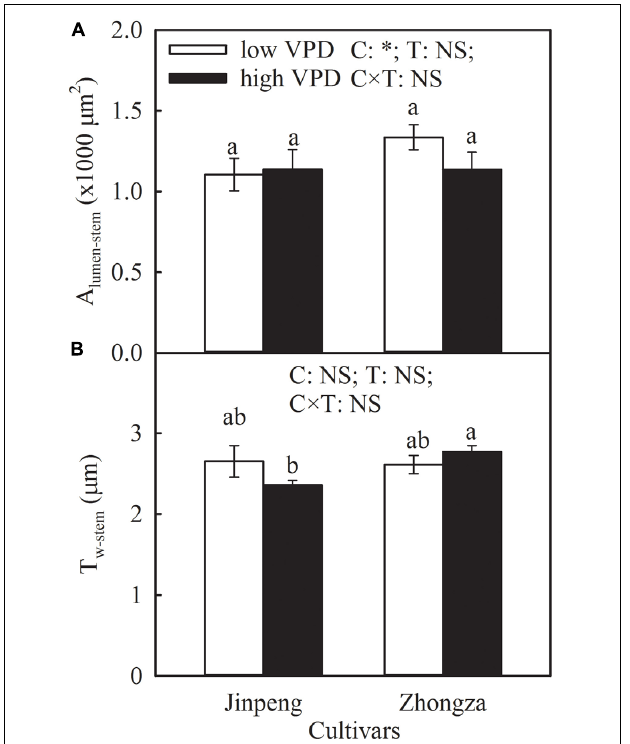
FIGURE 5 | Lumen area (A lumen - stem ) (A) and wall thickness (T w - stem ) (B) of vessels in stem for two tomato cultivars, Jinpeng and Zhongza, grown under low (1.1–1.5 kPa) and high (2.2–2.6 kPa) VPD. Data are means ± standard error ( n = 5 plants). Different letters denote statistically significant differences (Duncan’s test, P < 0.05). Two-way ANOVA was used to estimate the effect of cultivar (C), treatment (T), and their interaction (C × T) ( ∗ P < 0.05; NS, not